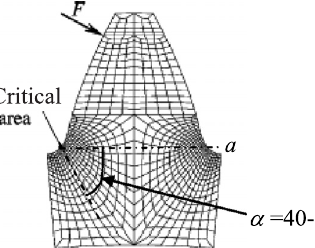
Fig. 6. The critical area of the tooth of the gear in gearbox. Table 3 Geometry of the crack fault in our